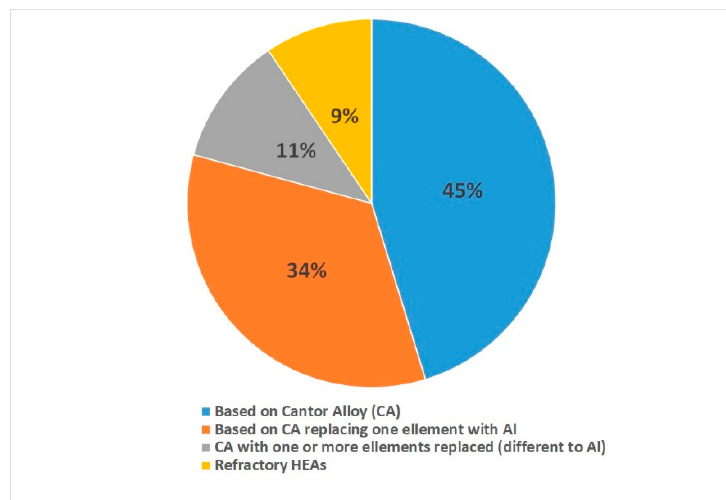
Figure 3. Types of alloys present in AM processes.